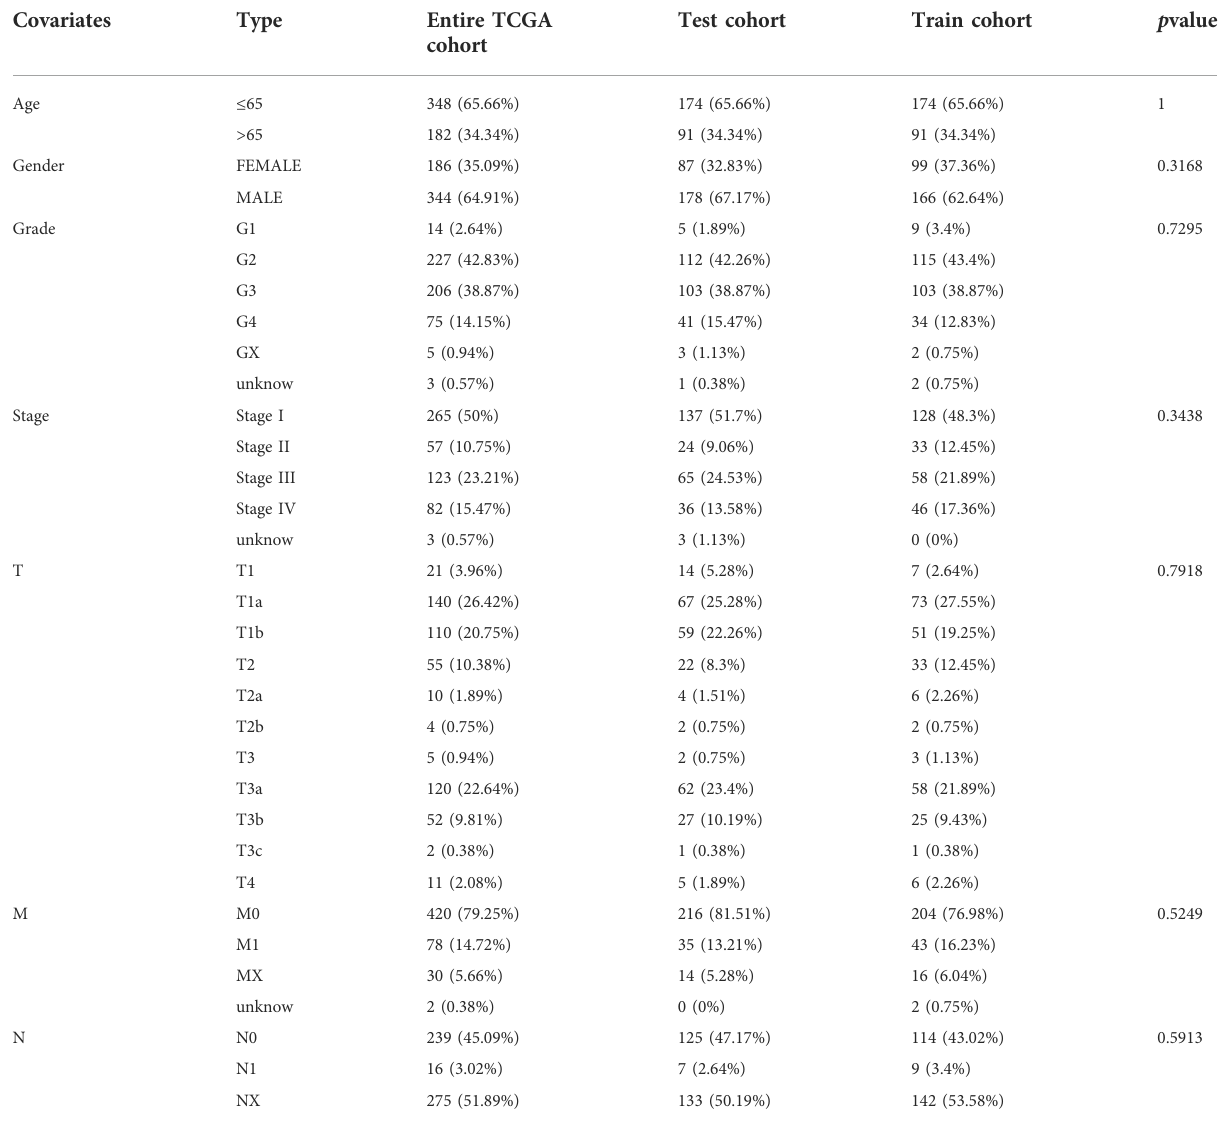
TABLE 1 Clinical information of KIRC patients in Train cohort, Test cohort, and Entire TCGA cohort.